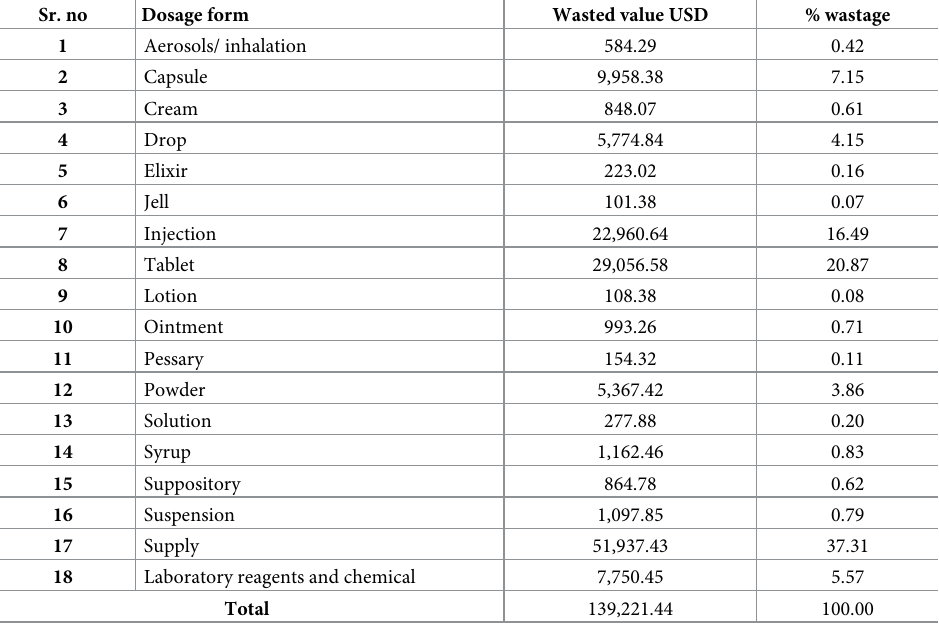
Table 3. Pharmaceuticals wastage rate by dosage form in public health facilities of Dessie town, Ethiopia, (n = 8). Sr. no Dosage